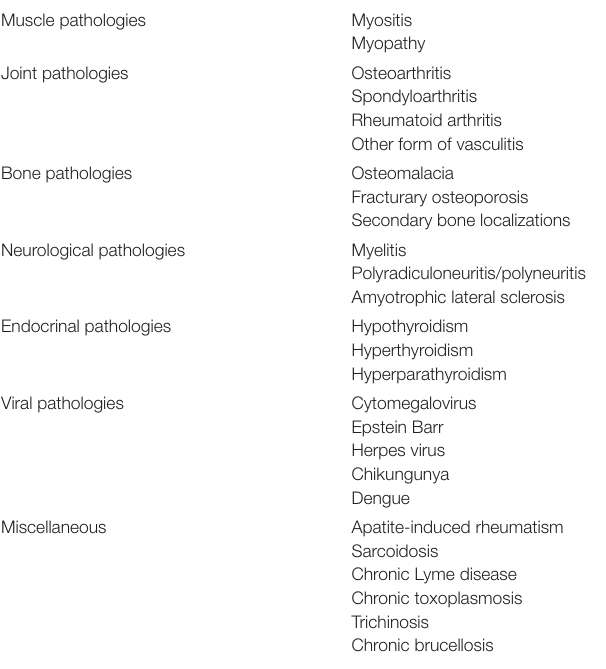
TABLE 1 | List of differential diagnoses to be eliminated by the rheumatologist in cases of diffuse pain. Muscle